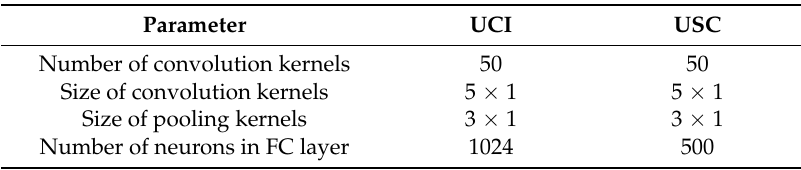
Table 2. Neural network parameters on different datasets. We only make convolution calculation on rows and keep the information of